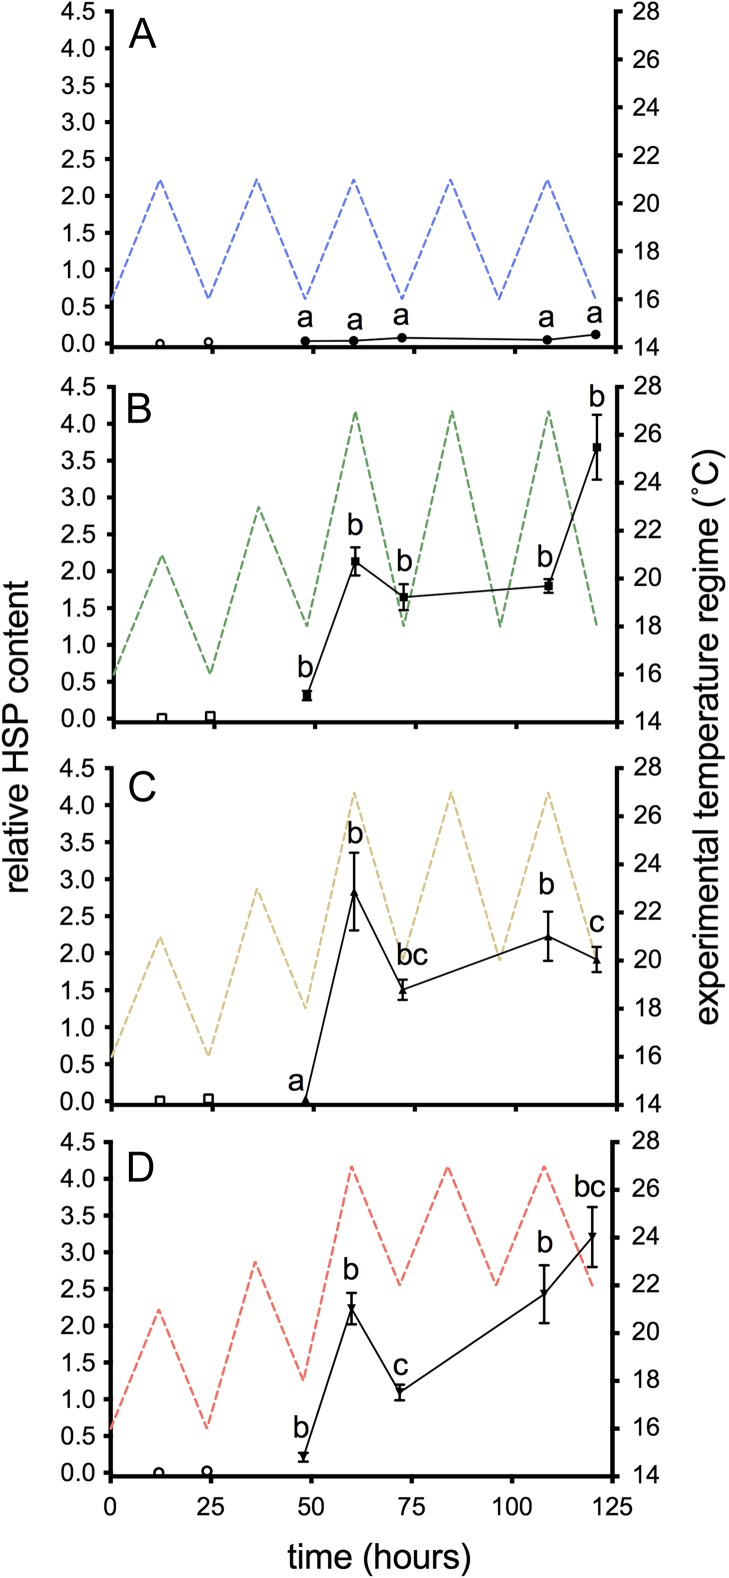
Liver HSP70 in juvenile salmon exposed to diel cycles: (A) 16–21°C only; or multi-day thermal stress (closed symbols; 60–120 h) of (B) 18–27°C; (C) 20–27°C; (D) 22–27°C. Data are presented as mean ± SEM (n = 5–9). Pre-thermal stress sampling (open symbols; t = 12 & 24 h) assessed the effect of ‘trial’ and was not included in the analysis. Letters indicate significant differences among treatments (P < 0.05) within sampling time points.